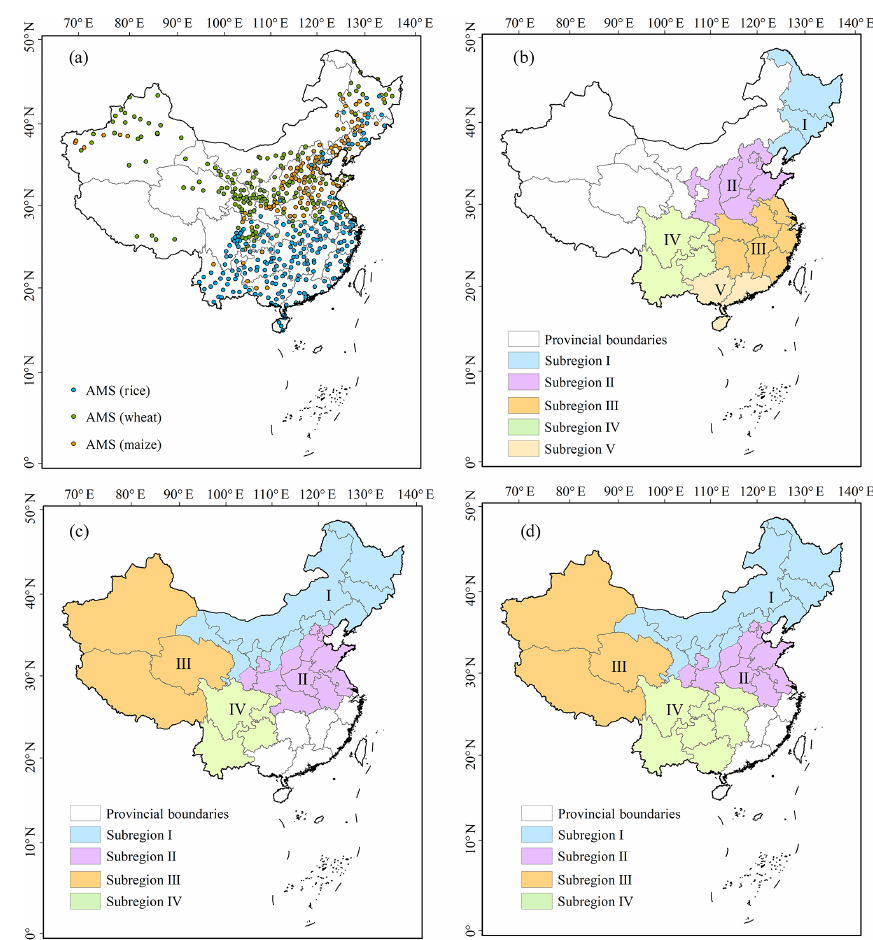
Figure 1. The spatial distribution of agricultural meteorological stations (AMSs) in studied areas (a) and the locations of divided subregions for rice (b) , wheat (c) and maize (d)